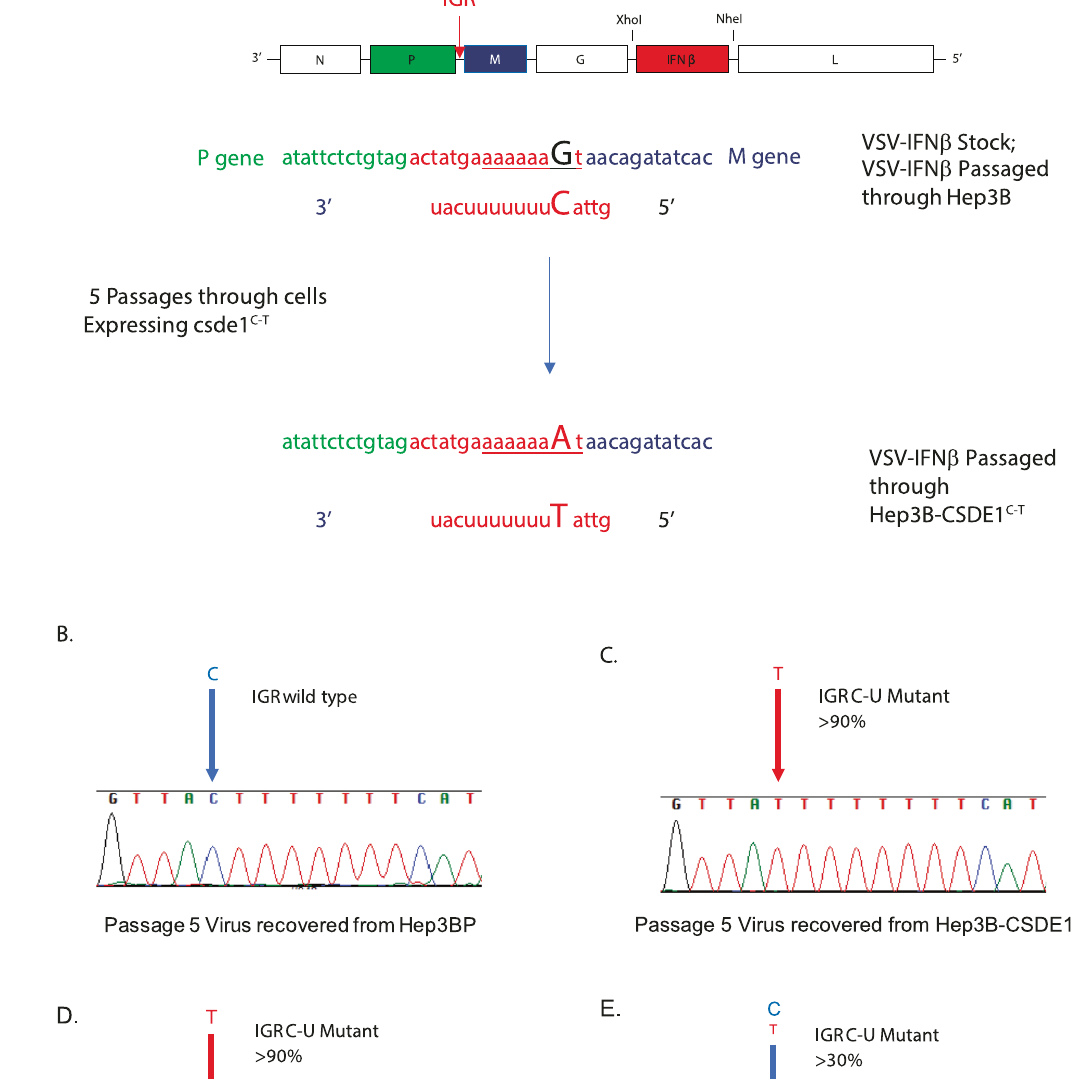
in viral positive sense transcripts when the positive sense genomic full-length strand is made during normal replication of the VSV genome (negative to positive RNA). Alternatively, it will exist if a sub-genomic, positive strand P – M mRNA is made when the polymerase reads through the P/M IGR to make a unicistronic P – M mRNA. Such readthrough is rare, because P and M mRNAs are usually made by disengagement of